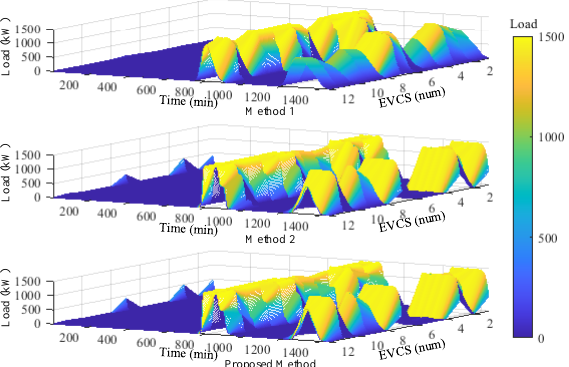
Figure 7. Load comparison of charging stations under different forecast methods. Table 4. Peak number of queuing vehicles, finish queuing time, and idle time difference comparison.